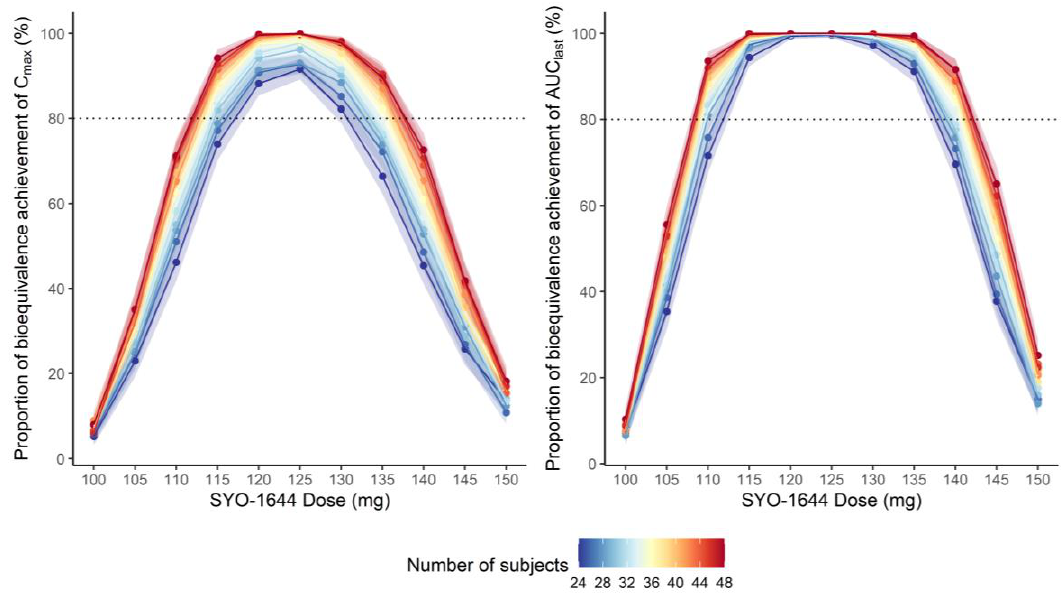
Figure 5. Proportion of bioequivalence achievement (left: C max , right: AUC last ) from simulated 2 × 2 bioequivalence trials for 500 times according to SYO-1644 dose and the number of subjects in each trial. Points represent proportion of bioequivalence achievement and areas represent 95% confidence intervals for proportion of bioequivalence achievement.